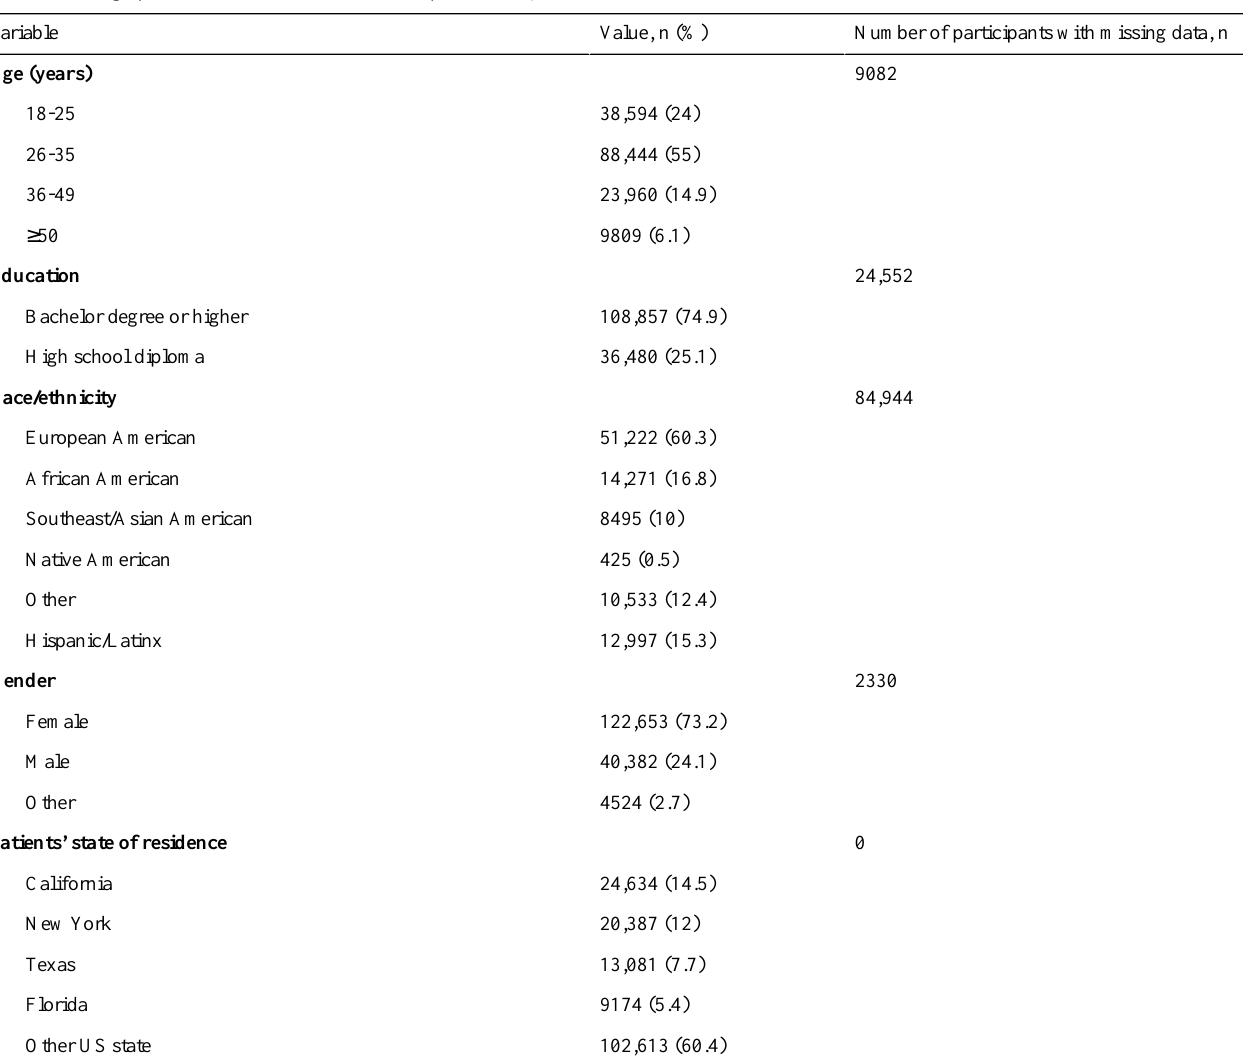
Table 2. Demographic characteristics of the full sample (N=169,889).